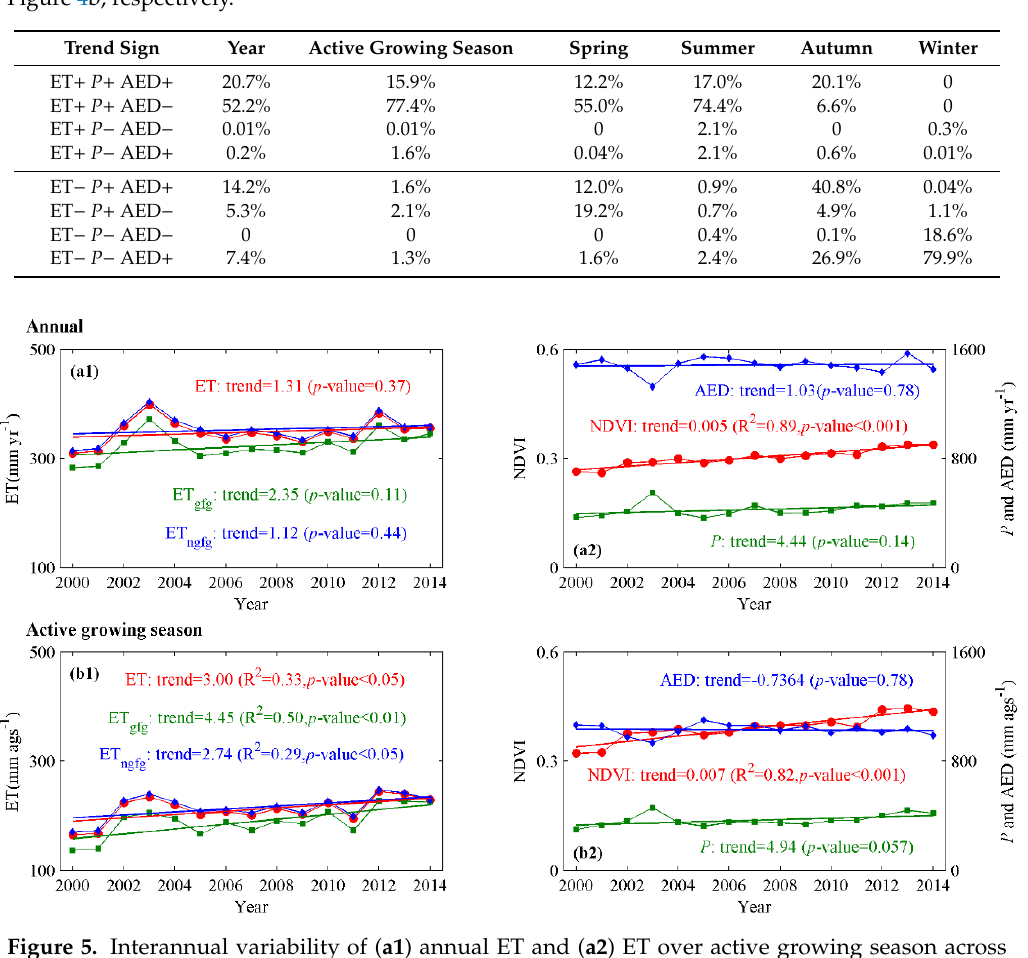
Figure 5. Interannual variability of ( a1 ) annual ET and ( a2 ) ET over active growing season across the entire CLP, along with main areas implemented with the GFG project (ET gfg ) versus other CLP areas not implemented with the GFG project (ET ngfg ) during 2000–2014 at the spatial-average level. The interannual variabilities of NDVI, P , and AED at the timescales of ( b1 ) annual and ( b2 ) active growing season across the entire CLP are also shown for reference. The broken lines with colors of red, green, and blue in the left panels show the interannual variability of ET across the entire CLP (denoted as ET), ET gfg , and ET ngfg , respectively, with annual trends (mm yr − 1 ) indicated by the texts in the same color. The broken lines and texts with colors of red, green, and blue in the right panels show the interannual variability and annual trends of NDVI, P , and AED, respectively.